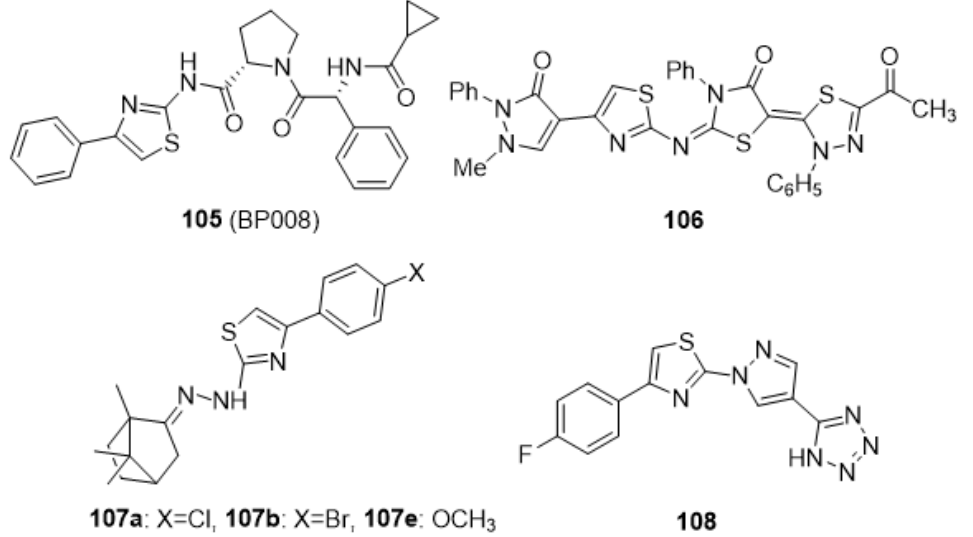
Figure 9. Thiazoles that have recently been designed and produced as possible antiviral